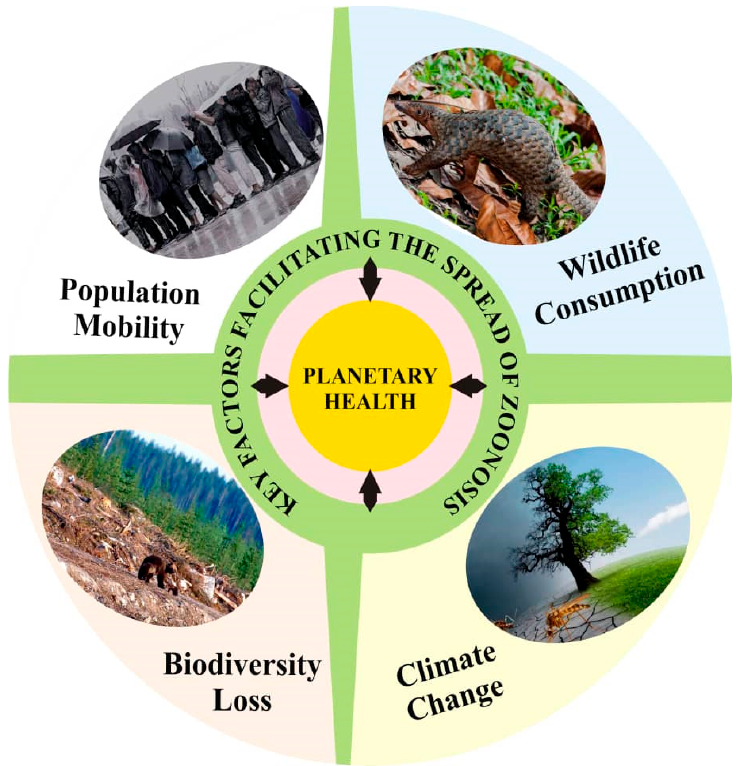
Figure 2. Key Factors Facilitating the Spread of Zoonosis.